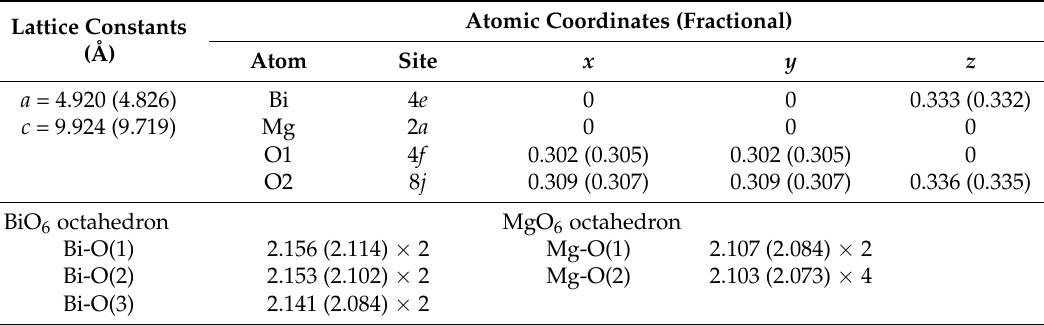
Figure 1. Crystal structure of the trirutile-type MgBi 2 O 6 represented as two different views. Table 1. Optimized structural parameters of MgBi 2 O 6 , Bi-O and Mg-O interatomic distances. The experimental values [17] are listed in brackets for comparison.